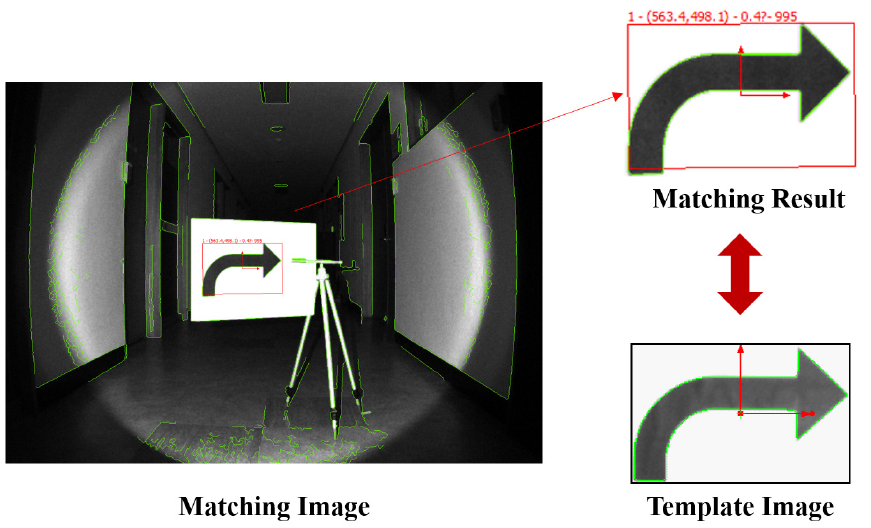
Figure 2. Matching result and template image of the geometric matching algorithm used in this study.